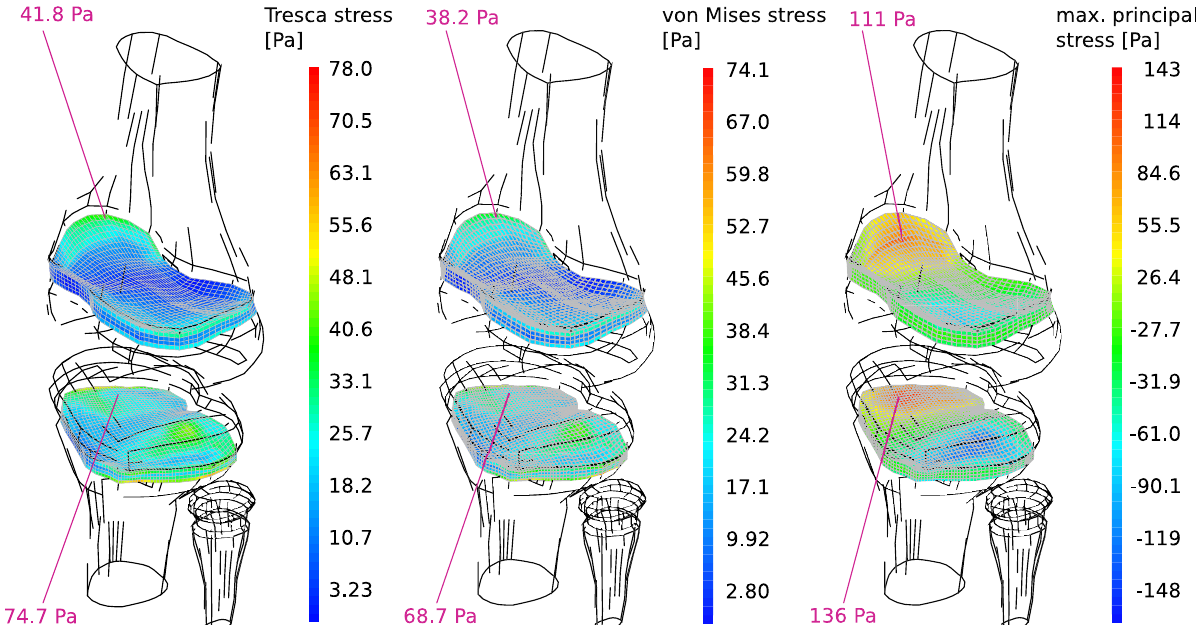
Figure 2. Stresses on the epiphyseal plate, for a unitary (1 Nmm) applied moment. Values and arrows in pink indicate the estimated stress peak level and its location, respectively. Maximum normal stress is the more conservative criterion for preventing epiphyseal damage, allowing a maximum applied moment of 1 . 1 Nm in order to not surpass a stress level of 0.153 MPa, considered to be safe 19 . Global error in the numerical solution was estimated in the order of 2% (Sup. Fig. 3), while material behavior related uncertainty in the computed stresses was estimated to be in the order of 1 . 5% (Sup. Fig. 4).